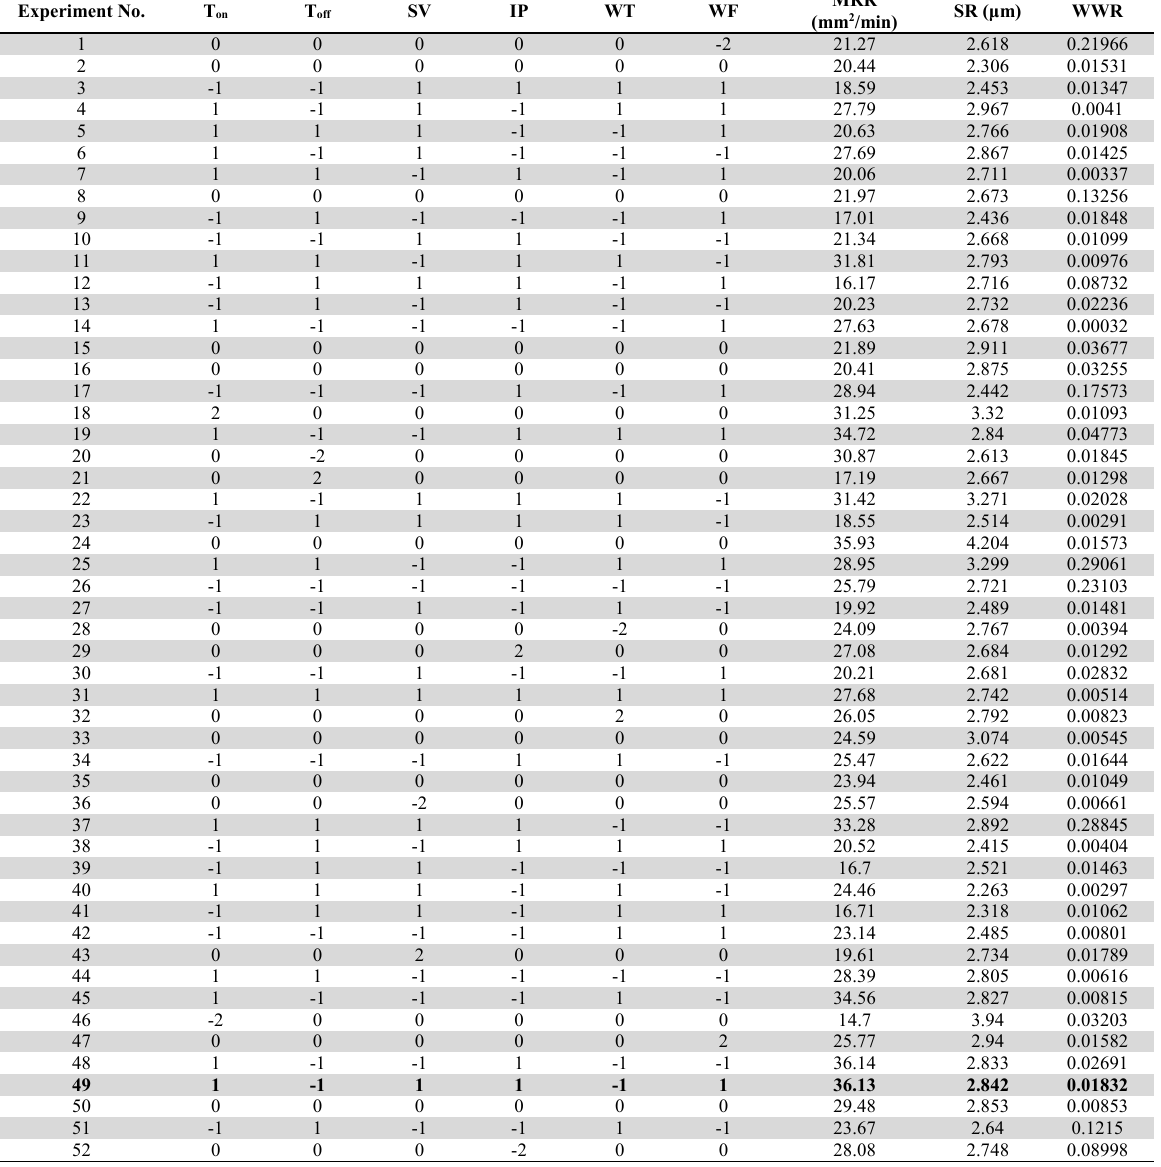
Central composite design of RSM and their responses Experiment